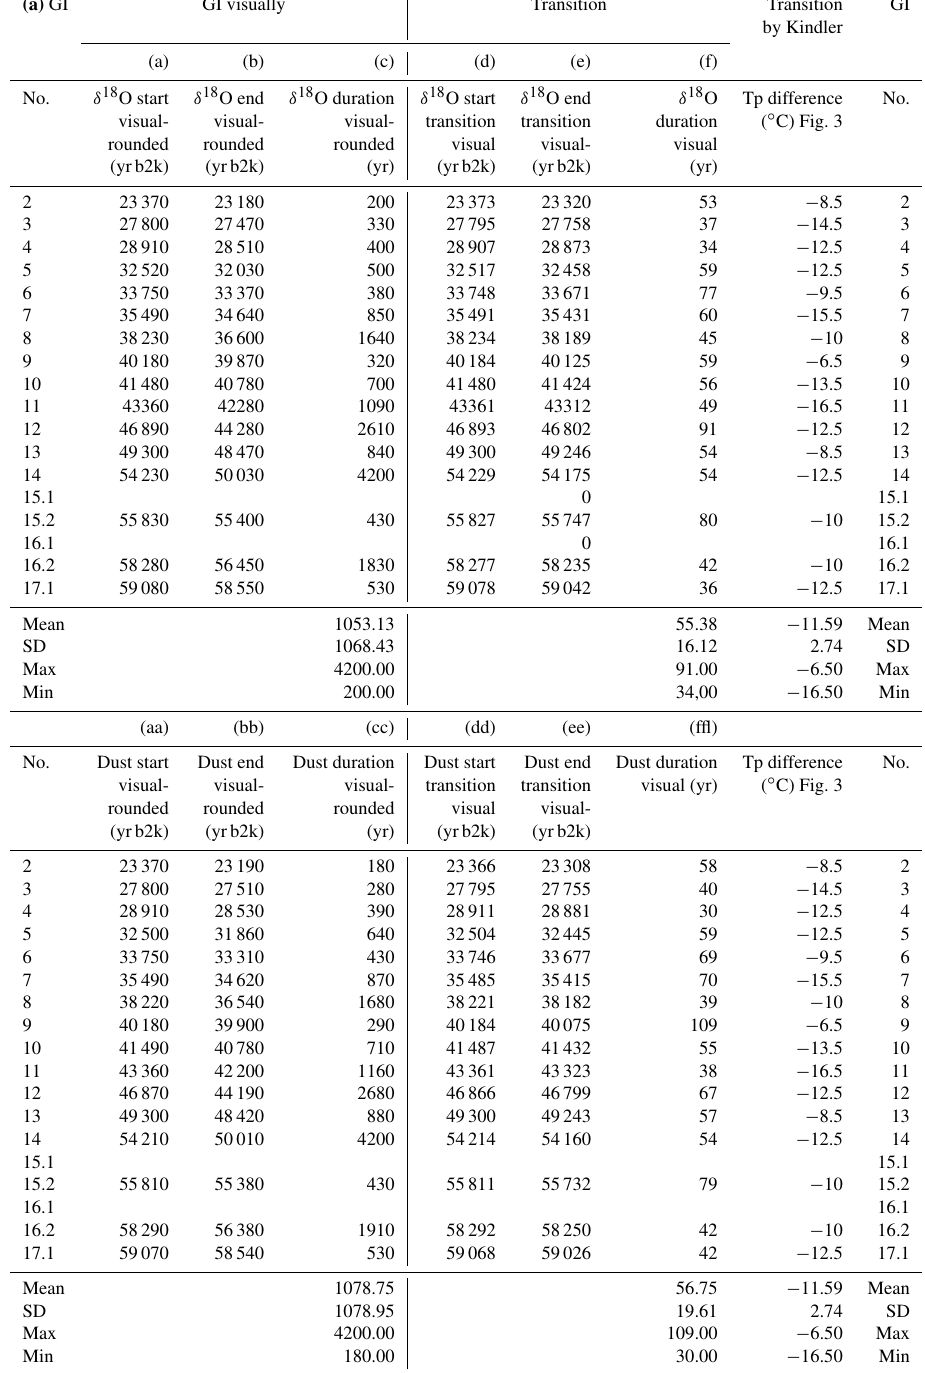
Table 1. NGRIP ice-core record. Estimates of NGRIP GI start, end, and duration and GI abrupt transition start, end, and duration (from Rousseau et al., 2017). Temperature reconstruction for the GI transitions as published by Kindler et al. (2014). Panels (a) and (b) show NGRIP transition dates determined visually and algorithmically,